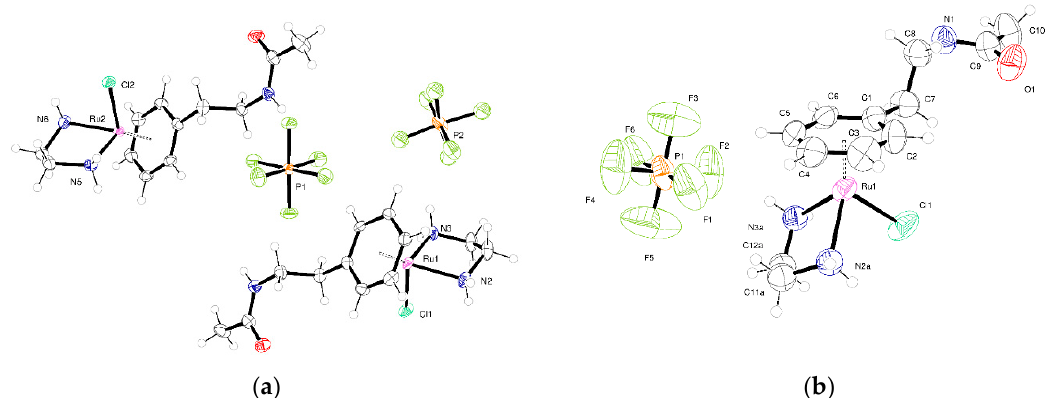
Figure 6. ( a ) Asymmetric unit of 6 at 100 K with atoms drawn as 50% displacement ellipsoids (small-scale disorder in one of the PF 6 − groups is not represented). ( b ) Asymmetric unit of 6 at 298 K with atoms drawn as 50% displacement ellipsoids (small-scale disorder in the ethylene diamine is not shown).